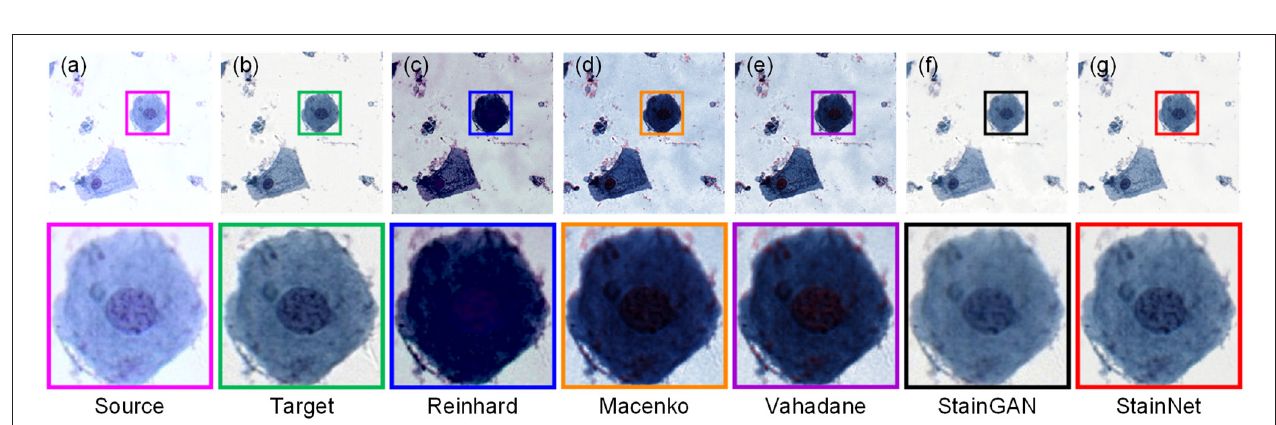
FIGURE 4 | Visual comparison of different normalization methods on the aligned cytopathology dataset. Source image (a) , target image (b) , and normalized image by Reinhard (c) , Macenko (d) , Vahadane (e) , StainGAN (f) , and StainNet (g) are listed.